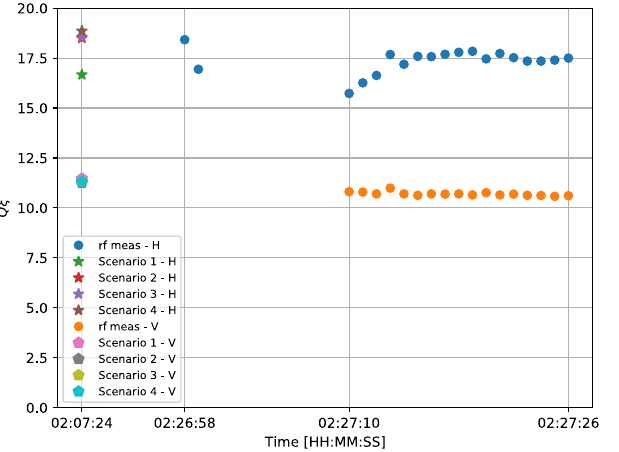
FIG. 8. Chromaticity measurements during LHC fill 7443.